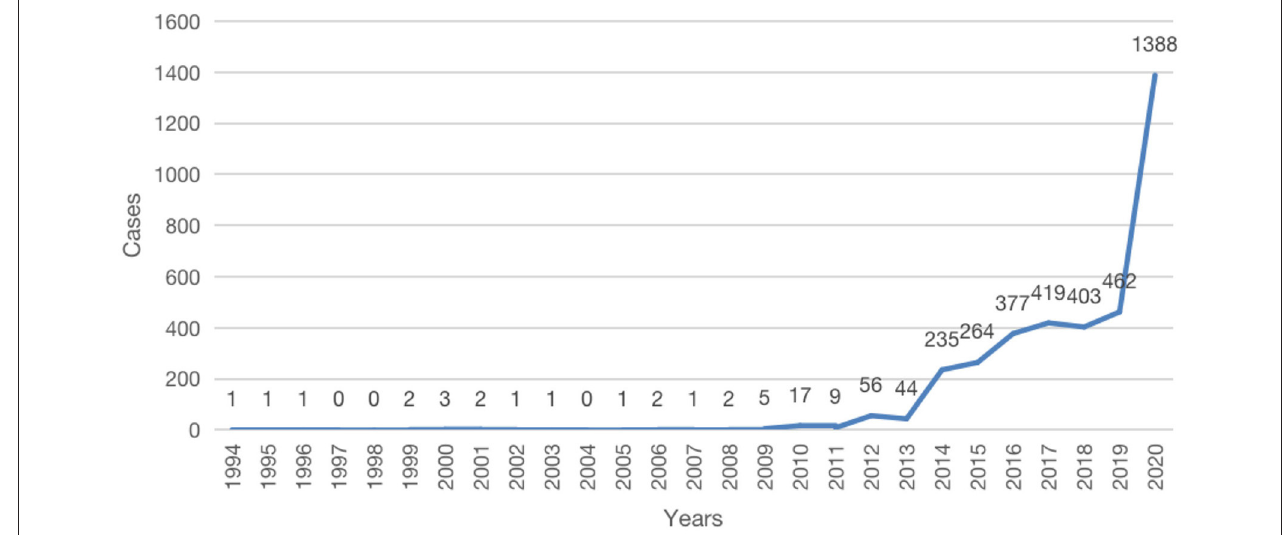
FIGURE 1 | Time heard distribution.